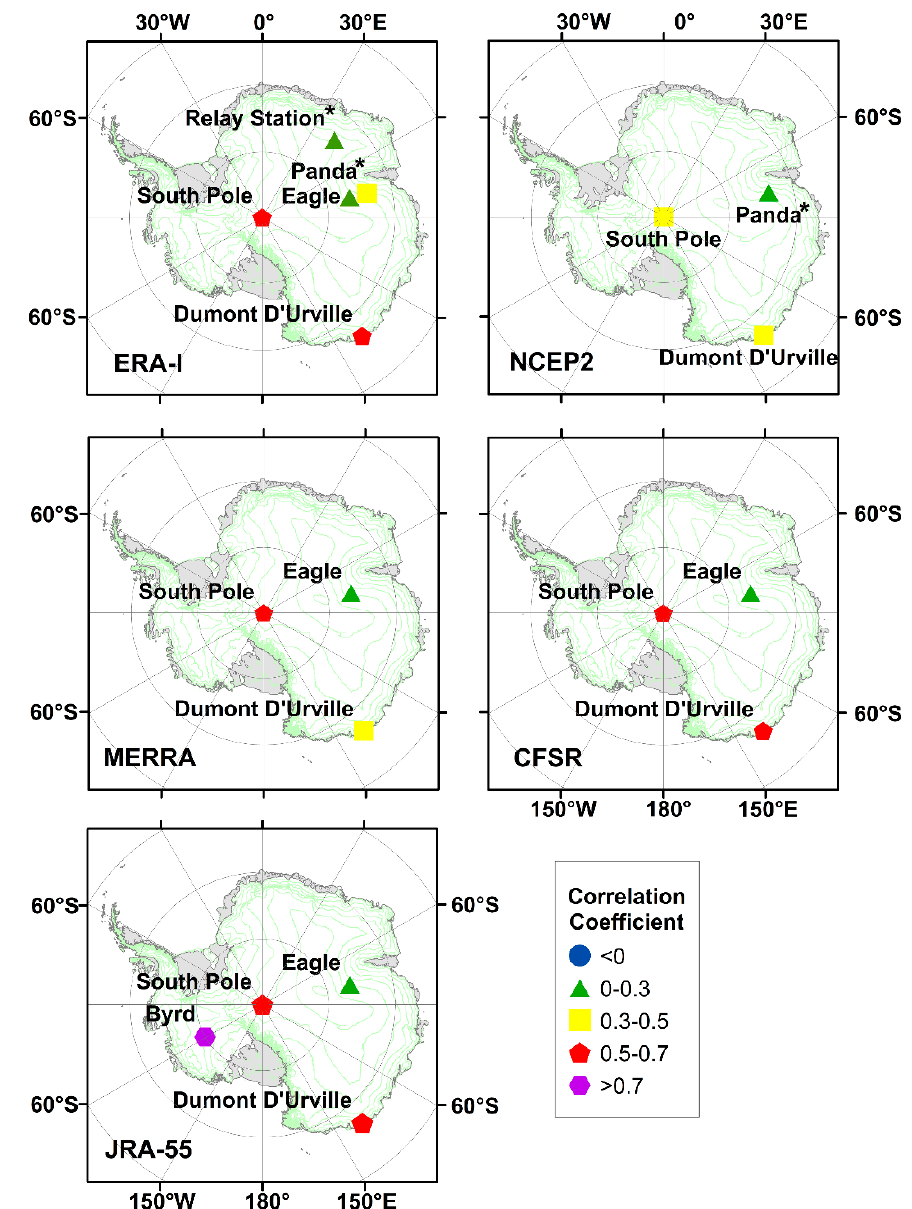
Figure 4. Maps show the monthly correlation coefficient values at the 95% significance level. Values marked with an asterisk are at the 90% significance level. AWSs with insignificant correlations are not shown in the figure.